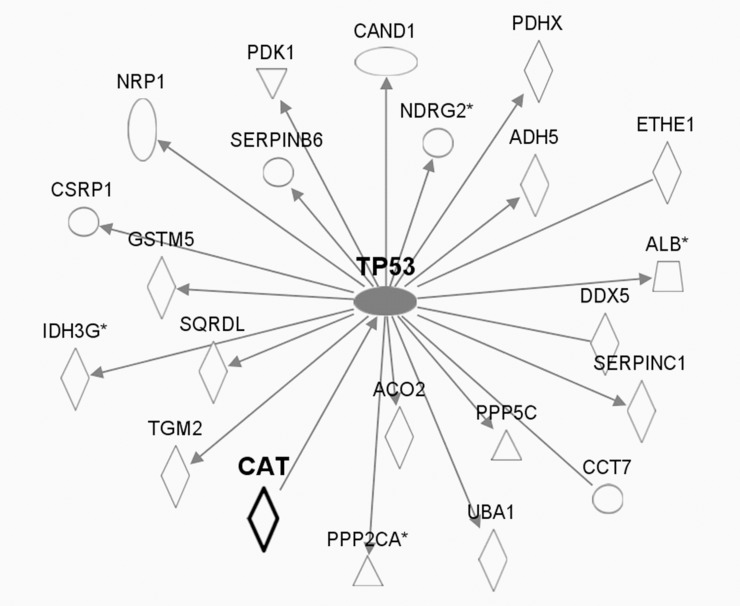
Pathway analysis-predicted protein networks associated with tumor suppressor p53.Legend to network analysis: enzyme (diamond), transmembrane receptor (vertical oval), transcriptional regulator (horizontal oval), phosphatase (triangle), transporter (trapezoid), kinase(triangle), growth factor (square), and other (circle). Relationships: interaction (line), activation (arrow).